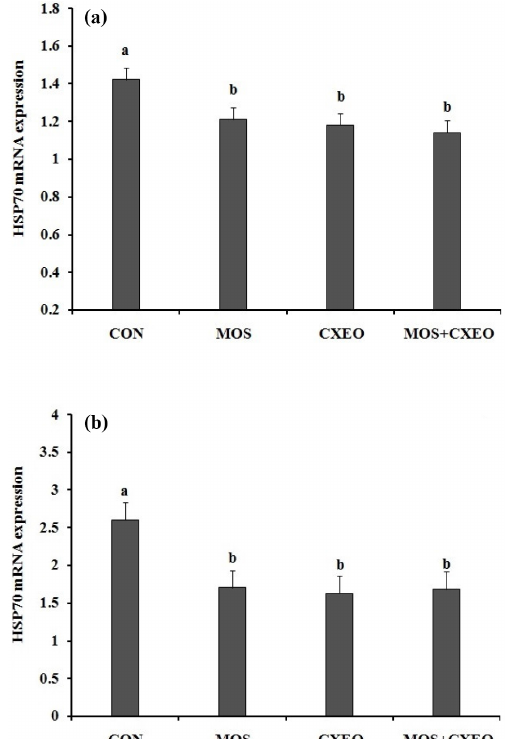
Figure 2. Effect of mannan oligosaccharide (MOS) and Curcuma xanthorrhiza essential oil (CXEO) on relative values of HSP70 mRNA expression in chicken breast muscle (a) and jejunum (b) . Mean values represent the average of 12 observations (six repli- cates × two birds / replicate). Values are means ± SEM. Within the graph, bars with different letters (a, b) are significantly different ( P< 0.05). CON: control group fed no additive. Other groups were fed 5gkg − 1 of MOS (MOS), 400mgkg − 1 of CXEO (CXEO), or 5gkg − 1 of MOS + 400mgkg − 1 of CXEO (MOS +